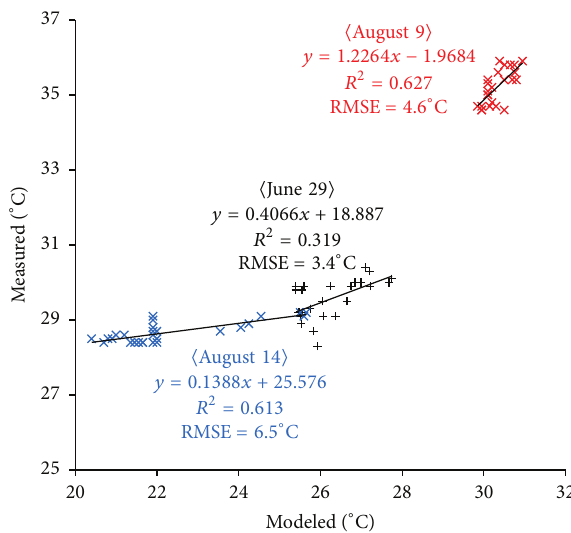
Figure 5: Comparison of the 2013 ENVI-met modeled and field measured temperatures for the following: 29 June: lower left set ( 𝑥 ), 09 August: central set (+), and 14 August: upper right set ( ∗ ).